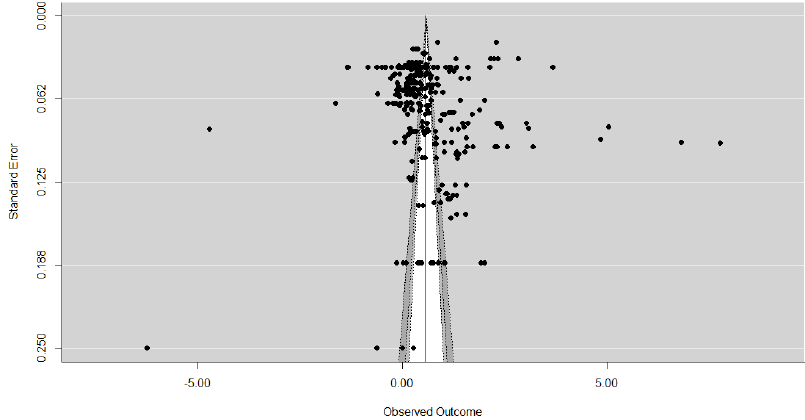
Figure 3. A contour enhanced funnel plot for overall values ( n = 335). Light grey is <1% significance, medium grey is 1%–<5% significance, dark grey is 5%–10% significance, and the white is the area of non-significance.